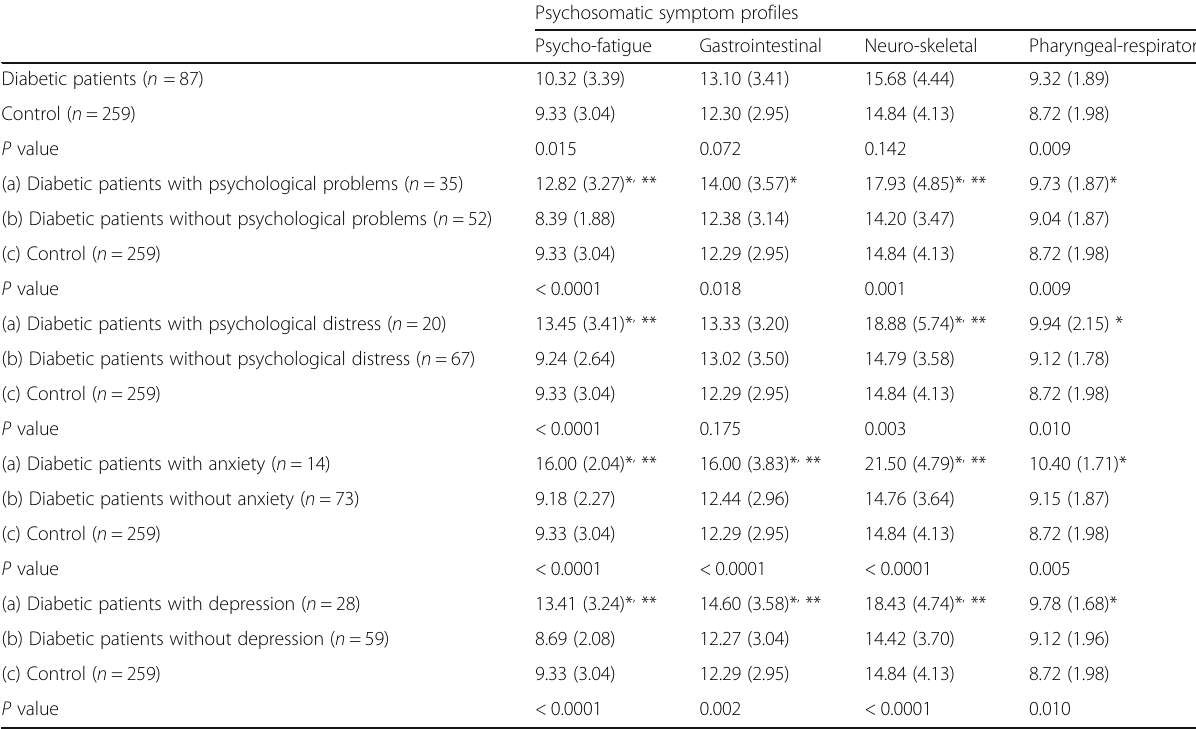
Table 4 Mean scores of psychosomatic symptom profiles in studied groups